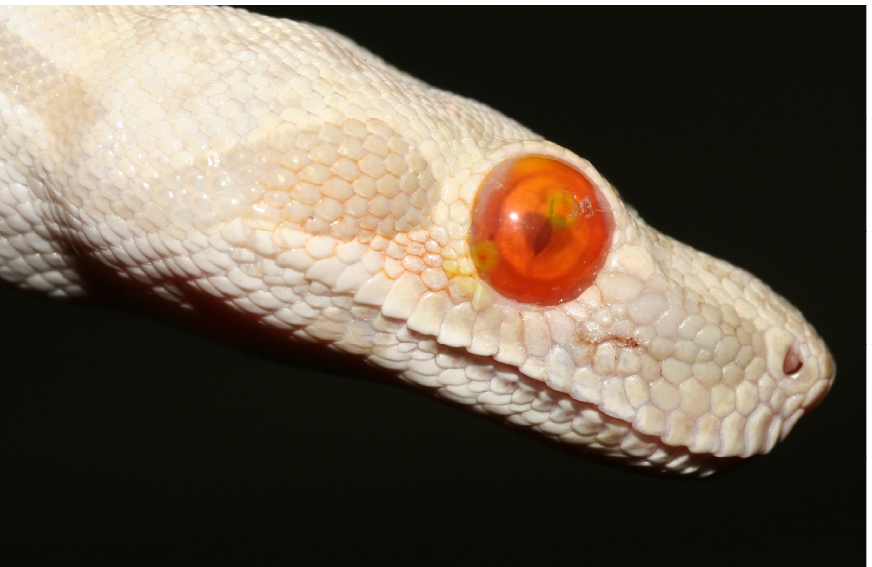
Figure 28. Boa constrictor ( Boa constrictor ) following percutaneous injection of a 1:5 balanced salt dilution of 10% fluorescein into the subspectacular space to ascertain patency of the lacrimal drainage system following treatment for pseudobuphthalmos.